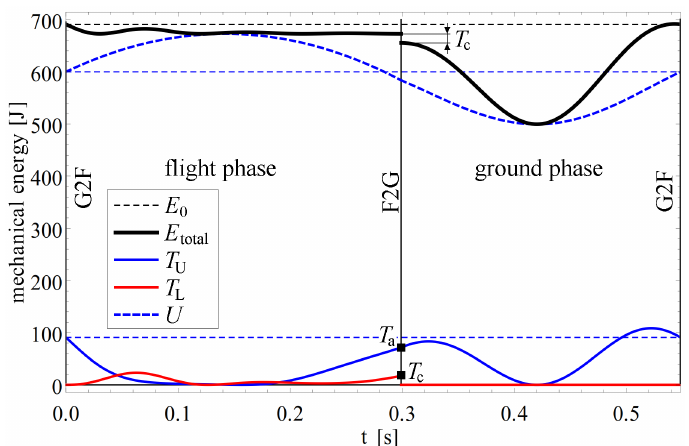
Figure 5. Time history of kinetic and potential energy. The absorbed amount of kinetic energy (CMSKE) and the remaining part are indicated by T c and T a respectively. The total mechanical energy E total converges to the nominal level E 0 in each